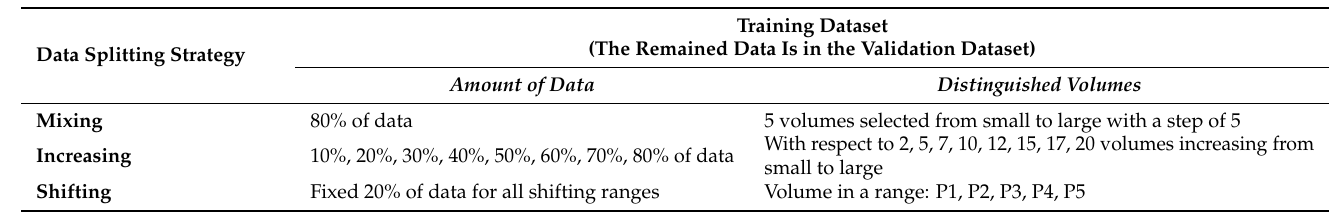
Figure 6. Training/validation dataset split strategies based on corrosion volume to evaluate the performance of machine learning algorithms: selection of corrosion for training dataset with 20% data of the entire volumes (mixing), 20% corrosion shifting from low to high volumes ( P i =1:5 ), and increasing volumes from low to high (20~80%). Table 2. Dataset splitting strategy and its corresponding amount of data and distinguished volumes.